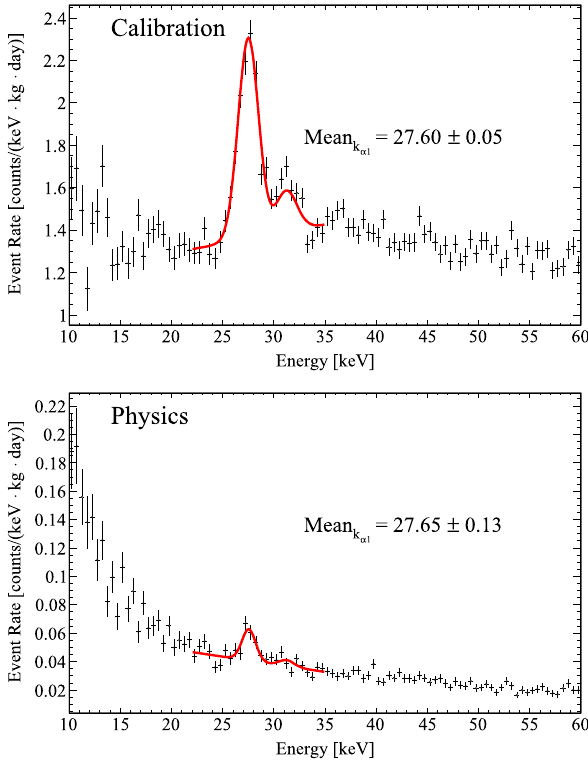
Fig. 4 CUORE-0 summed energy spectra of events with double- crystal coincidence incalibration(top) and physics (bottom) data, along with fits to an eight-Gaussian line shape plus linear background (red solid lines)